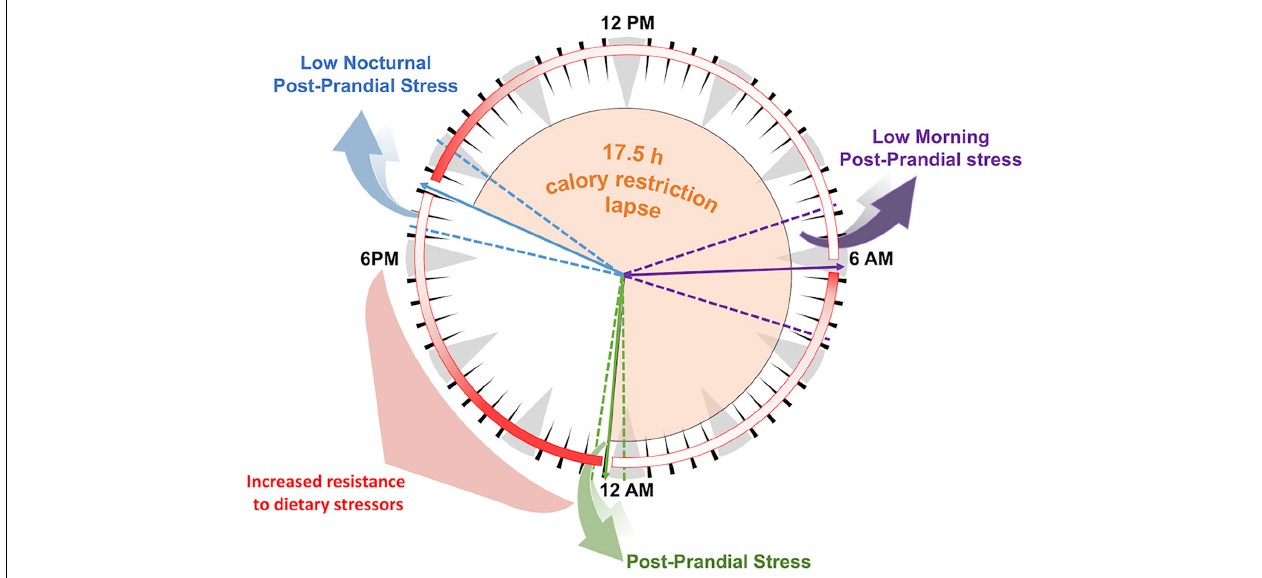
FIGURE 5 | Graphical representation of the day’s mealtimes and of the fasting/calorie restriction lapse for nonagenarians and centenarians from Abruzzo. The arrows within the clockface indicate the median time of meal consumption: purple: breakfast; green: lunch; and blue: dinner. Dotted lines represent the earliest and latest time of each meal consumption. Light-orange areas represent an average time of restricted calorie intake. Red shaded circle areas represent hypothesized postprandial stress periods after each meal, the bolder the red, the greater the postprandial